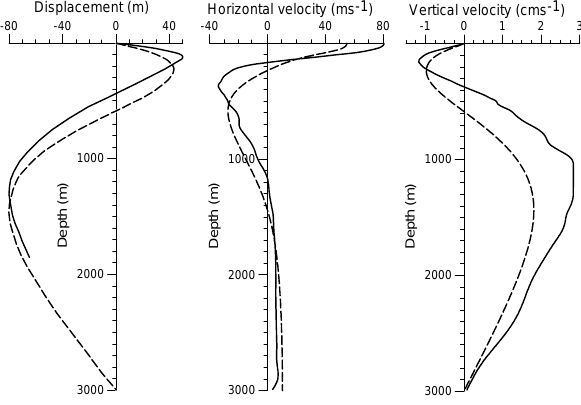
Fig. 6. Vertical profiles of a second-mode solitary wave in its centre (fragment A 2 , Fig. 4b) as predicted by numerical model (solid lines) and calculated from a standard boundary-value problem (dashed